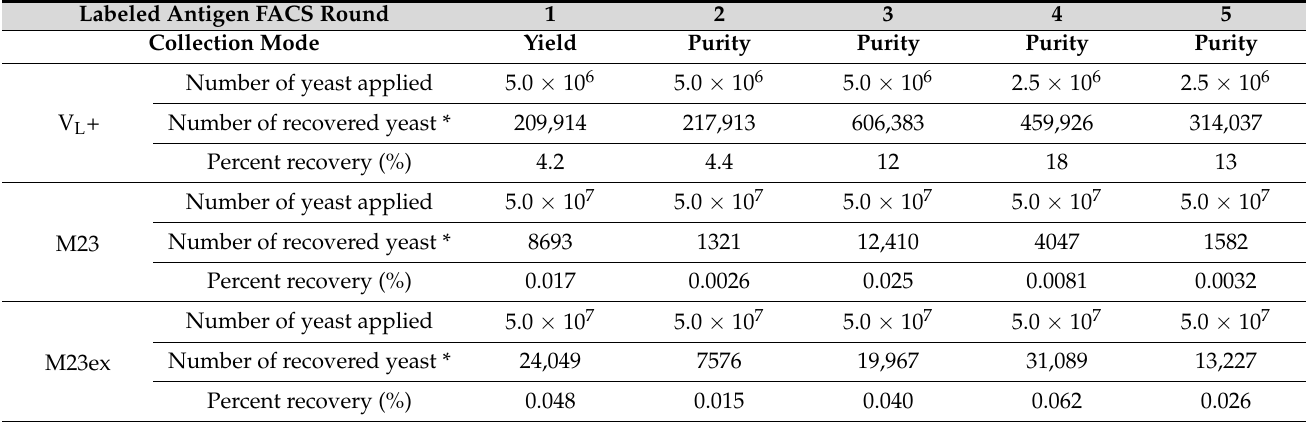
Table 2. Summary of FACS library screening parameters and